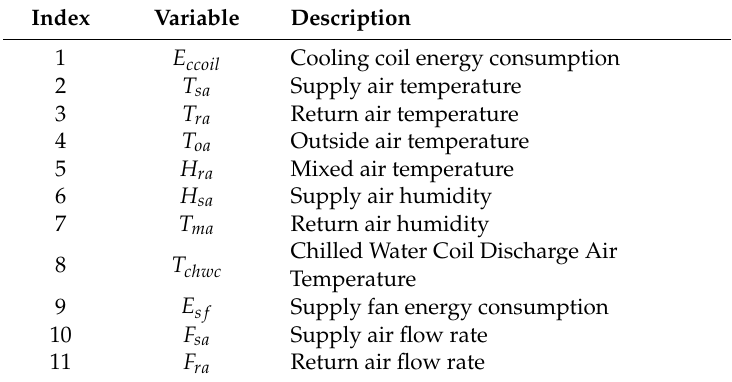
Table 1. Top 11 important feature variables selected based on CS-SFS algorithm